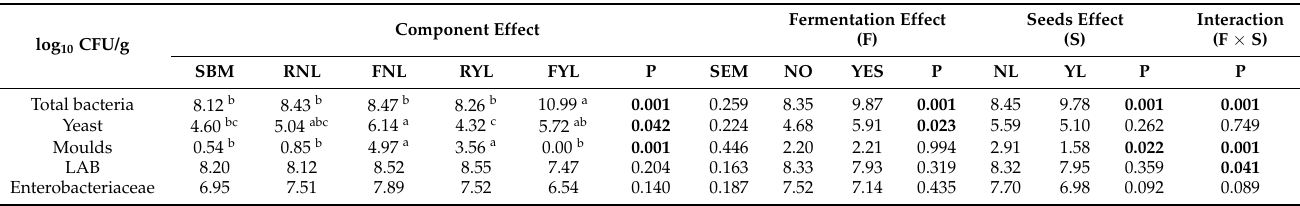
Table 5. The microflora content in the ileal digesta ( n =